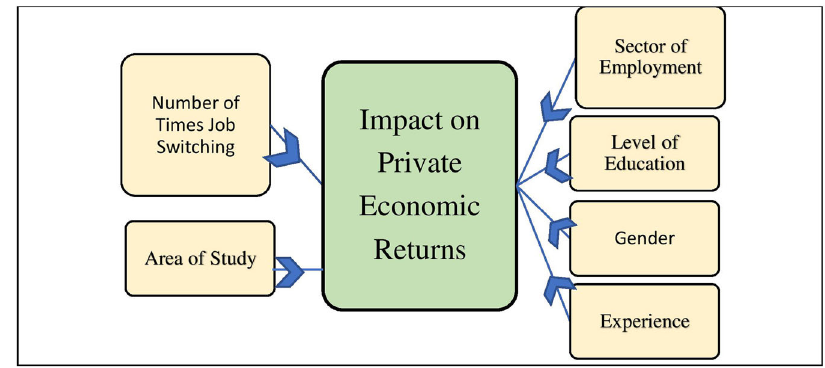
Fig. 3 Conceptual framework of the study. It shows the effect of independent variables on private economic returns.